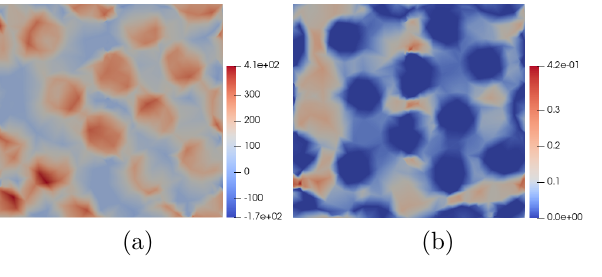
Figure 19. Carbon composite with maximal stiffness, time = 100 s: a) Shear stress [MPa], b) creep